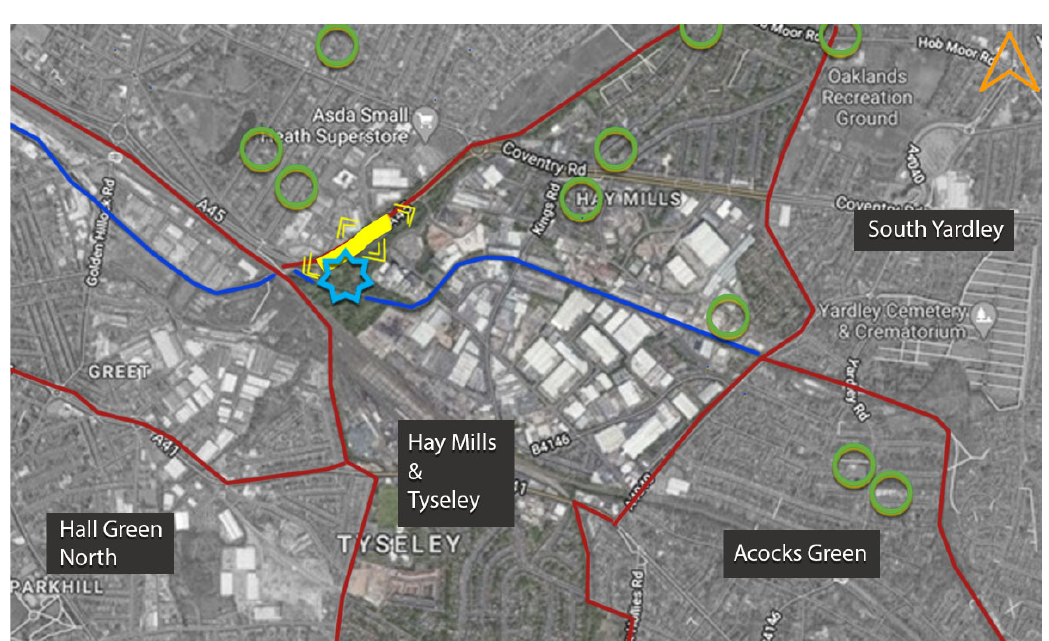
Figure 4. Stakeholder area mapping combined central blue-green space (yellow), an innovation hub (blue), and educational facilities